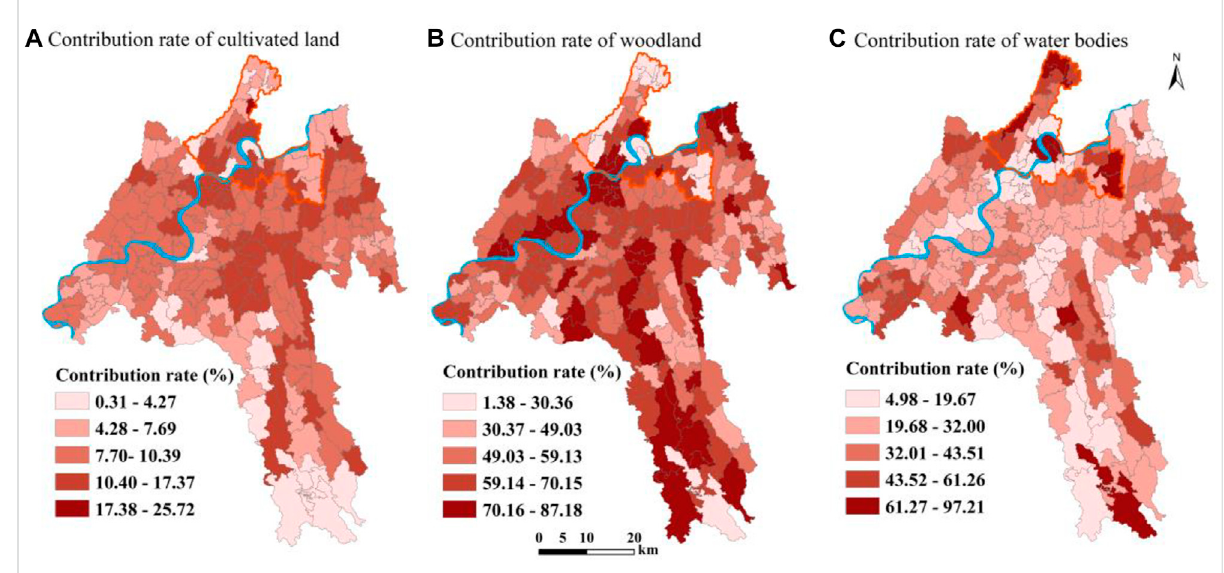
FIGURE 7 Contributionrateof landuse ecosystemservice valuechange inJiangjin from 2009to 2019. (A) :contribution rate ofcultivated landfrom 2009 to 2019; (B) : contribution rate of woodland from 2009 to 2019; (C) : contribution rate of water bodies from 2009 to